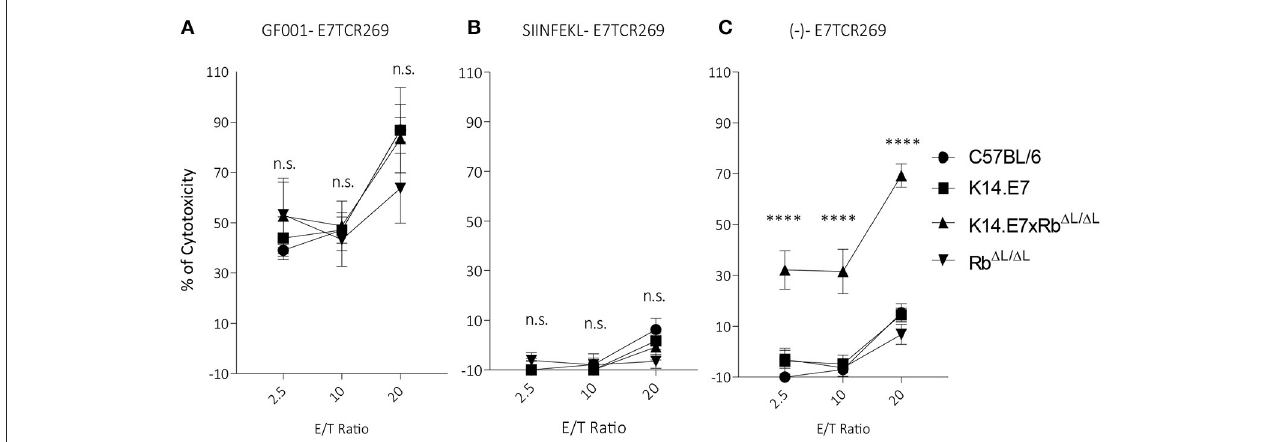
FIGURE 4 | Keratinocytes from K14.E7xRb 1 L /1 L skin present endogenous antigen and are susceptible to CTL-mediated lysis. Keratinocytes isolated from the epidermis of C57BL/6, K14.E7, K14.E7xRb 1 L /1 L , and Rb 1 L /1 L mice were pulsed with (A) GF001 peptide (B) SIINFEKL peptide or (C) without peptide (-) and co-cultured with E7-specific effector T cells (E7TCR269) at the shown effector/target (E/T) ratios. Keratinocyte death was assessed as LDH release above background from no-peptide pulsed KC and effector T cell alone. Two independent experiments were done. Target cell maximum release and spontaneous release of LDH are plotted in Supplementary Figure 4 . Data analyzed using two-way ANOVA and applied with Bonferroni post-test. Error bars showing mean ± SEM with 3 to 5 biological replicates in each experimental group. Result significance was shown, where **** p <